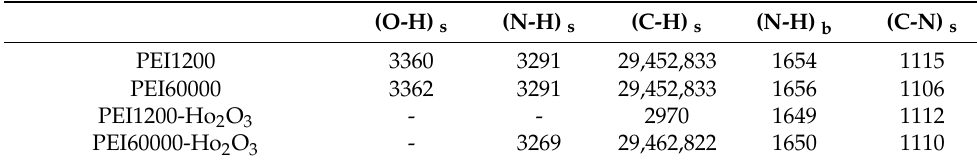
Figure 5. ( a ) FT-IR absorption spectra of PEI1200 and PEI60000 and PEI1200- and PEI60000-coated ultrasmall Ho 2 O 3 nanoparticles. Subscripts “s” and “b” indicate stretching and bending vibrations, respectively. ( b ) TGA curves of PEI1200- and PEI60000-coated ultrasmall Ho 2 O 3 nanoparticles. ( c ) PEI-coating structure: each nanoparticle is grafted with approximately fifteen PEI1200 polymers (left), multiple hard acid–hard base type of bondings (middle), and approximately two nanoparticles grafted with one PEI60000 polymer (left). Table 2. Observed FT-IR absorption frequencies (in cm ‒ 1 ) a .